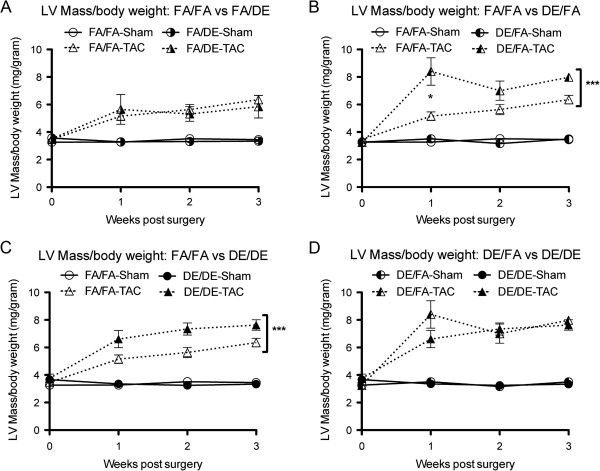
Echocardiographic assessment of calculated LV Mass normalized to body weight over time following transverse aortic constriction (TAC) or sham surgeries. (A) FA/FA (n = 7 sham, n = 8 TAC) vs. FA/DE (n = 3 sham, n = 3 TAC), (B) FA/FA vs. DE/FA (n = 5 sham, n = 5 TAC), (C) FA/FA vs. DE/DE (n = 5 sham, n = 4 TAC) groups, and (D) DE/FA vs. DE/DE.